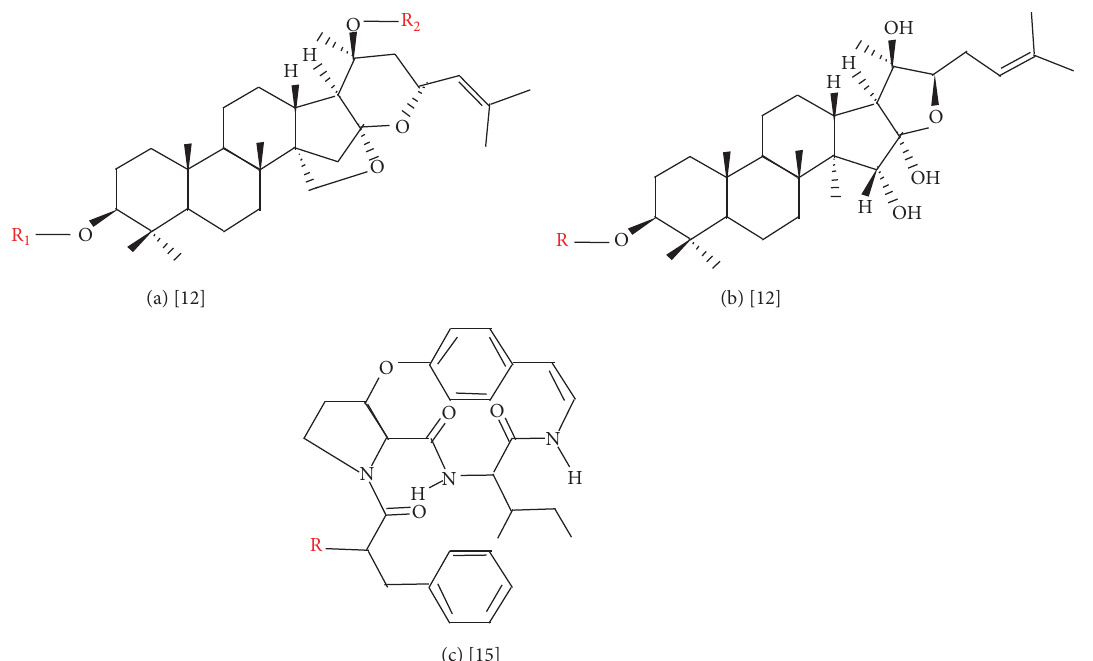
Figure 1: Common structure of jujubogenins (a), lotogenins (b), and lotusines (c) found in Z. lotus [12, 15–17,